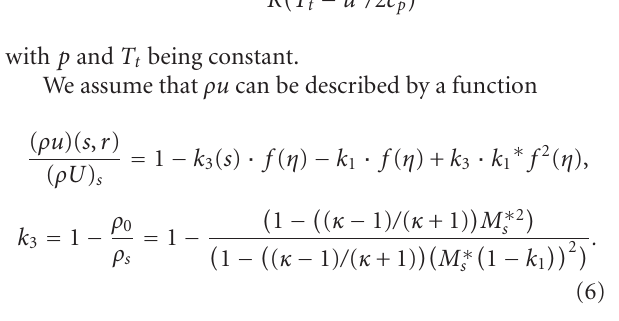
Figure 1: Problem definition and coordinates.